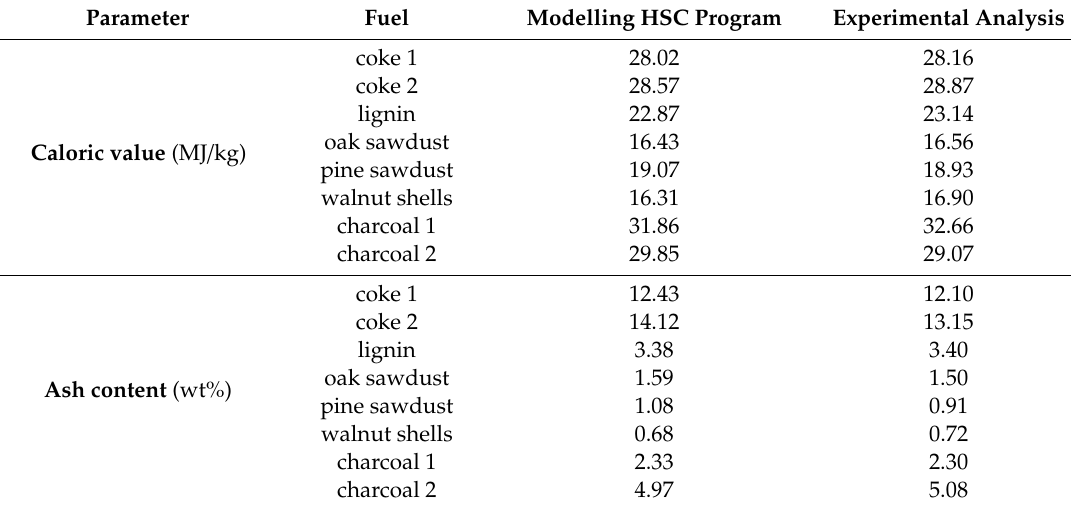
Table 6. Parameters of fuel combustion.